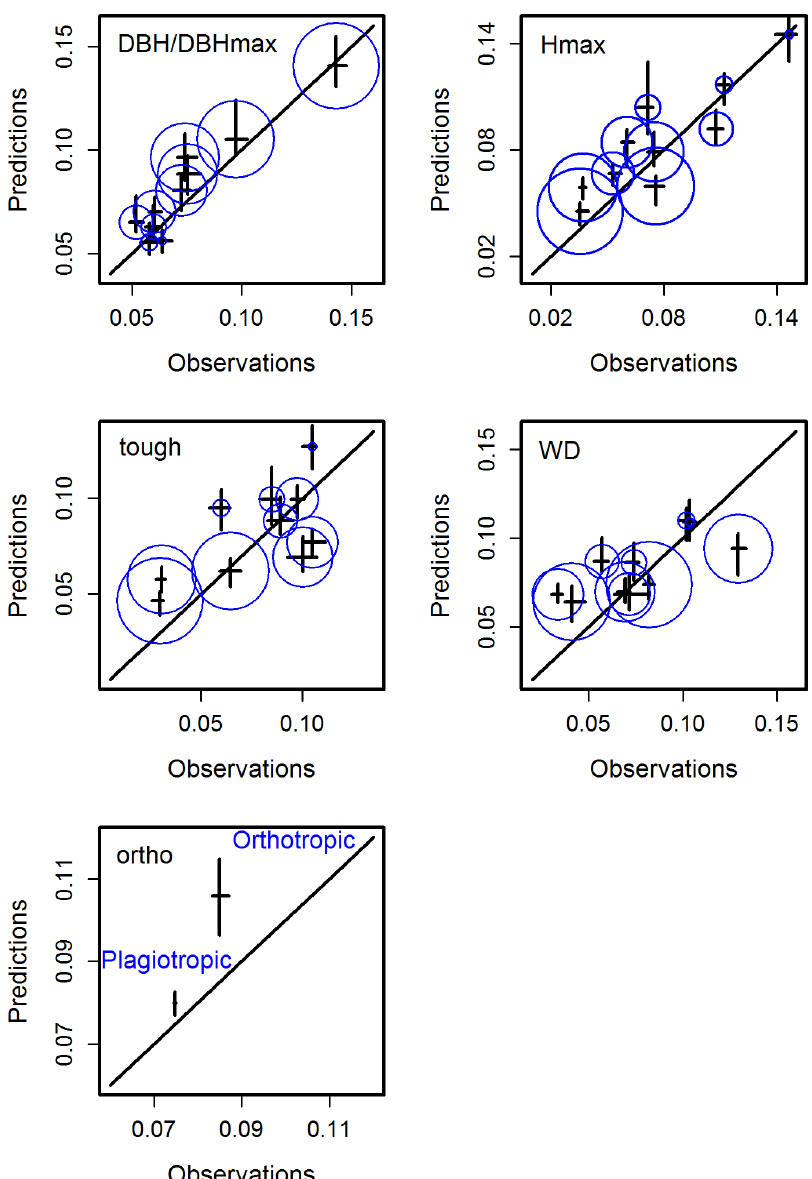
Figure 7. Model validation: the model was calibrated using data from 1992 to 2001 and applied to a validation data set (2001– 2010). For each covariate of the mortality model, we binned individuals into ten bins of equal size, corresponding to the deciles of the covariate distribution. Mortality rates were then computed for each bin using the validation data set (2001–2010). Predictions were plotted against observed rates. Moreover, the size of the blue circle is proportional to the value of the median of each